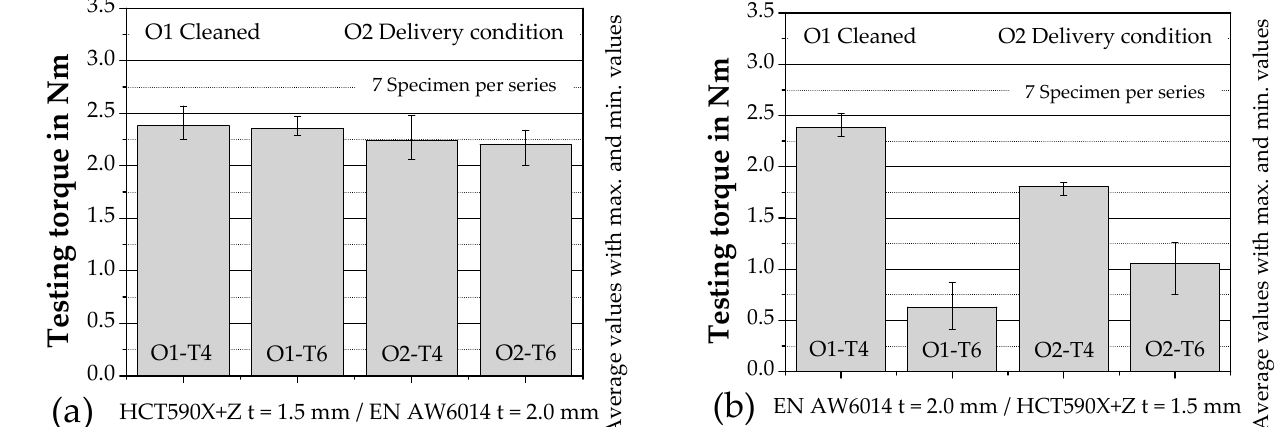
Figure 4. Torsion test by variation of joining direction and surface condition .